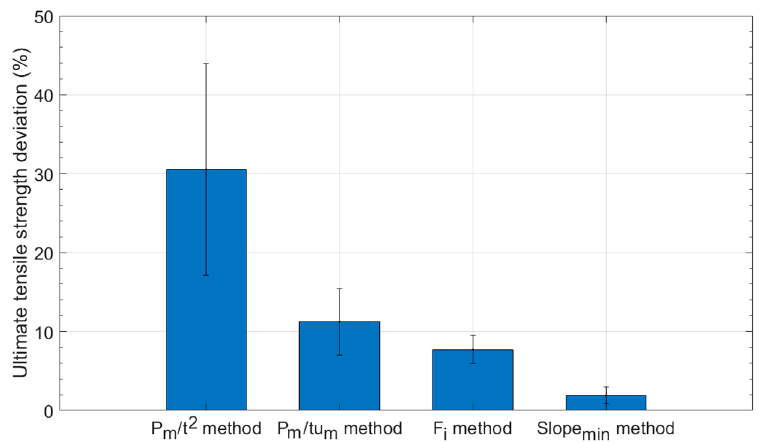
Figure 17. Deviations of the ultimate tensile strength calculation.